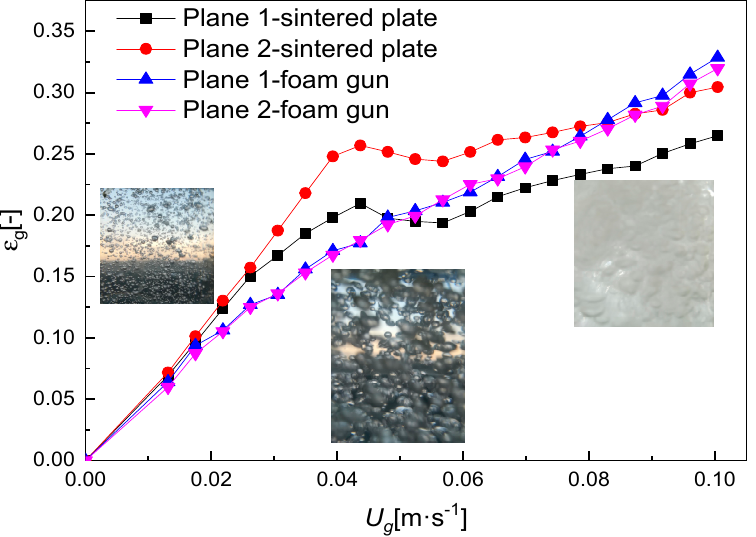
Figure 4. E ff ect of the superficial gas velocity on average gas holdup at di ff erent planes. Figure 4. Effect of the superficial gas velocity on average gas holdup at different planes. Figure 5 selects the cross-section gas holdup measured by ERT using two di ff erent gas distributors (sintered plate and foam gun) under the superficial gas velocities 0.026 m / s, 0.052 m / s, 0.079 m / s and 0.100 m / s. It can be seen that the foam gun as a gas distributor has a significantly higher gas holdup than the sintered plate, and the cross-section gas holdup in the column is evenly distributed at a low superficial gas velocity. In the same cross-section, the gas holdup gradually decreases from the center along with the radial position and is symmetrically distributed. Compared with traditional measuring methods, ERT expresses the change in the gas holdup in the column intuitively and visually, which is more conducive to understanding the flow in the bubble